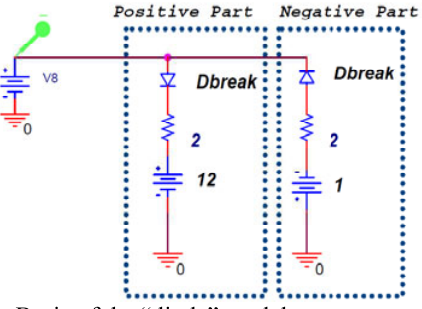
Figure 13: Advanced “diode” model typical structure